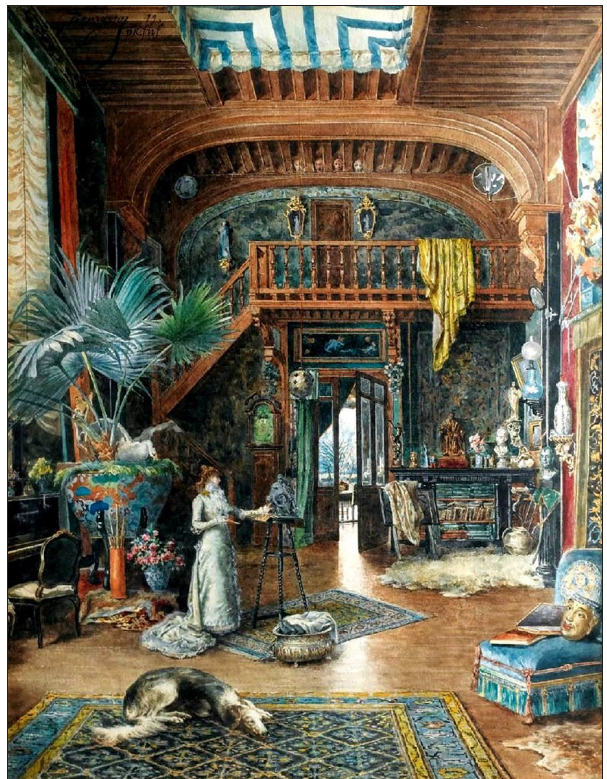
Fig. 5 : Marie-Désiré Bourgoin, L’Atelier de Sarah Bernhardt , 1879, watercolour and gouache over graphite, 67.8 × 53.1 cm, Metropolitan Museum, New York. © Metropolitan Museum of Art, New